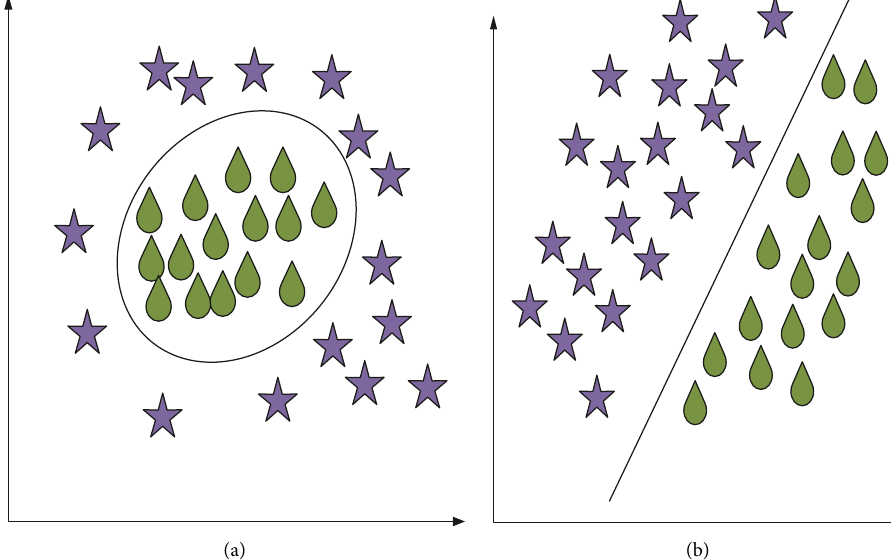
Figure 6: SVM mapping diagram. (a) The original space is linearly inseparable. (b) The mapped space is linearly inseparable.